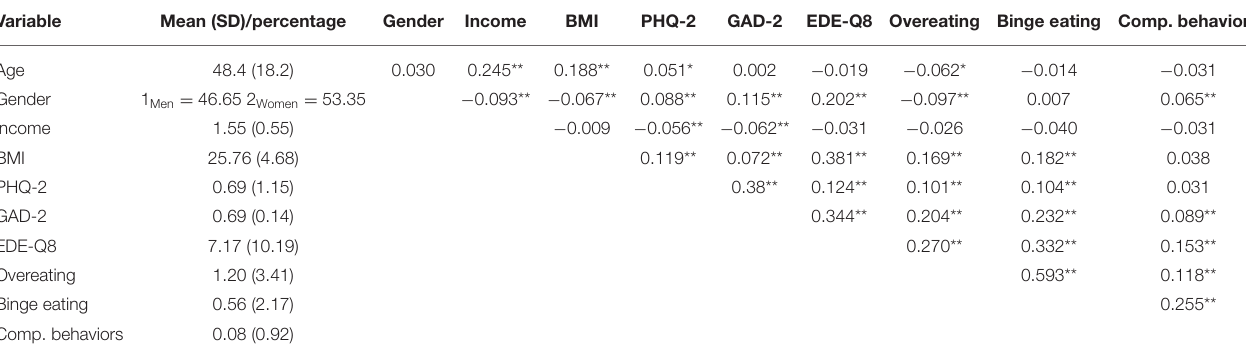
TABLE 1 | Means, standard deviations, and correlations among measures. Variable Mean (SD)/percentage Gender Income BMI PHQ-2 GAD-2 EDE-Q8 Overeating Binge eating Comp. behaviors